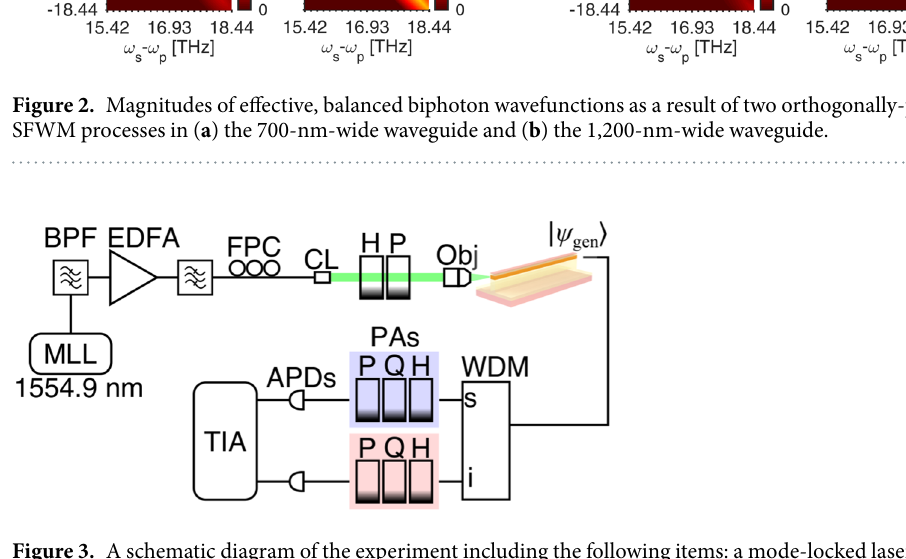
Figure 3. A schematic diagram of the experiment including the following items: a mode-locked laser (MLL), an erbium-doped fiber amplifier (EDFA), 1-nm band-pass filters (BPF), a fiber polarization controller (FPC), a fiber collimator (CL), quarter-wave plates (Q), half-wave plates (H), polarizers (P), an objective lens (Obj), a set of WDM filters, polarization analyzers (PA), avalanche photodiodes (APDs), and a time interval analyzer